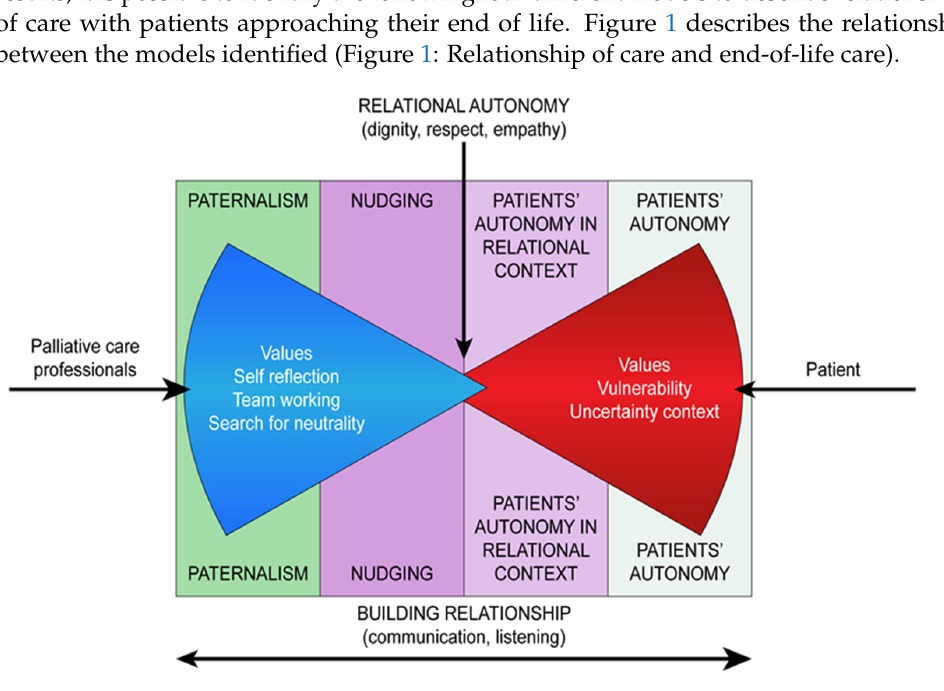
Figure 1. Relationship of care and end-of-life